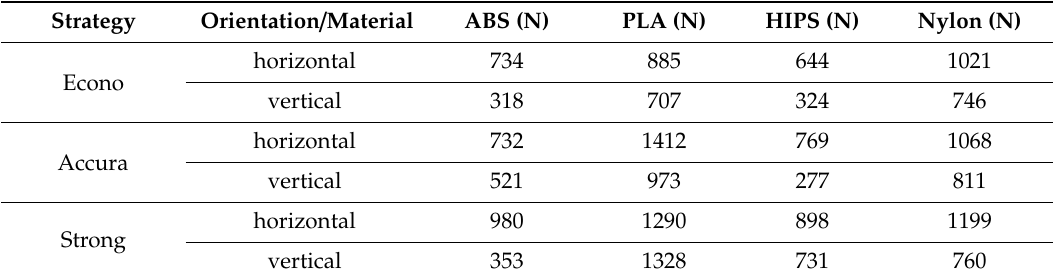
Table 3. Summary of strength tests—force at break for various process combinations.